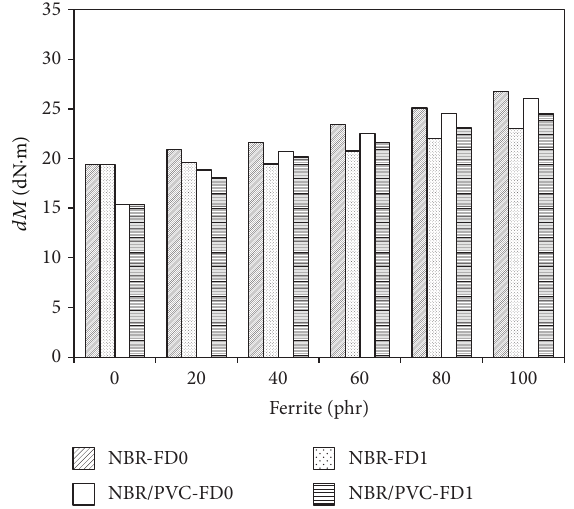
Figure 3: Influence of ferrites content on torque difference 𝑑𝑀 of rubber compounds.